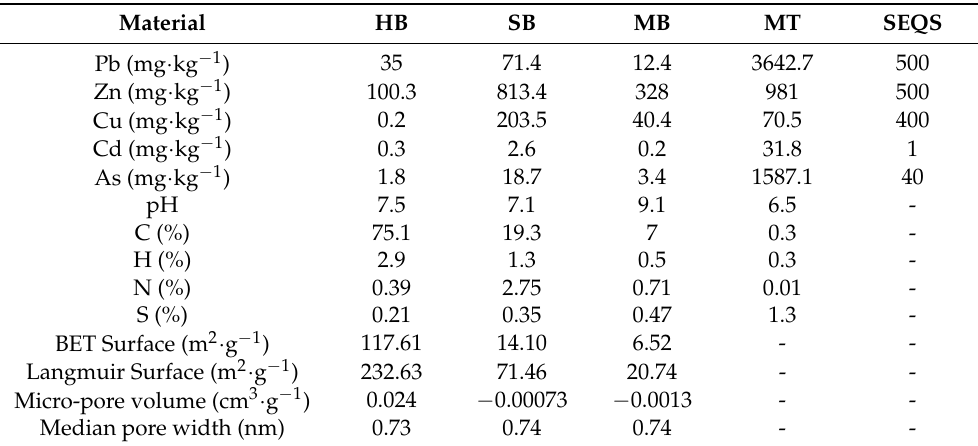
Table 1. Basic properties of mine tailings and different